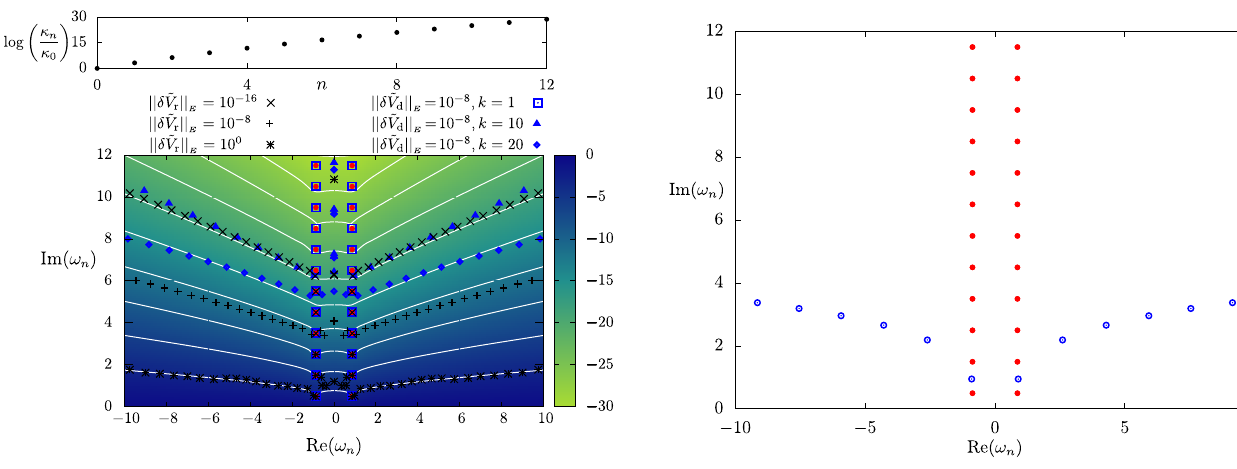
FIG. 10. QNMs of the Pöschl-Teller cut potential. Setting the ; x Pöschl-Teller potential to zero outside an interval ½ x min max (cid:3) introduces high-frequency perturbations that make QNM over- tones migrate towards pseudospectrum contour lines, as well as an “ infrared ” modification that alters the fundamental QNM frequency. Whereas the latter tends to the nonperturbed Pöschl- → −∞ and x → ∞ , QNM overtones Teller value as x min max always remain strongly